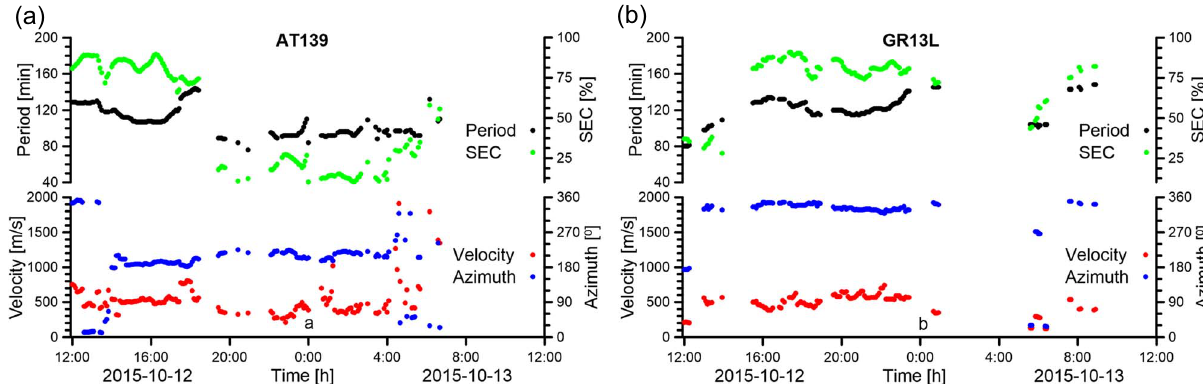
Fig. 7. Results of detection of the LSTID activity by the HF-Int over two stations located in (a) Europe and (b) South Africa for the time interval from 12UT on October 12 to 12UT on October 13 of 2015. Red dots show velocity, blue dots show azimuth, black dots show period and green dots show spectral energy contribution (SEC). See text for details.